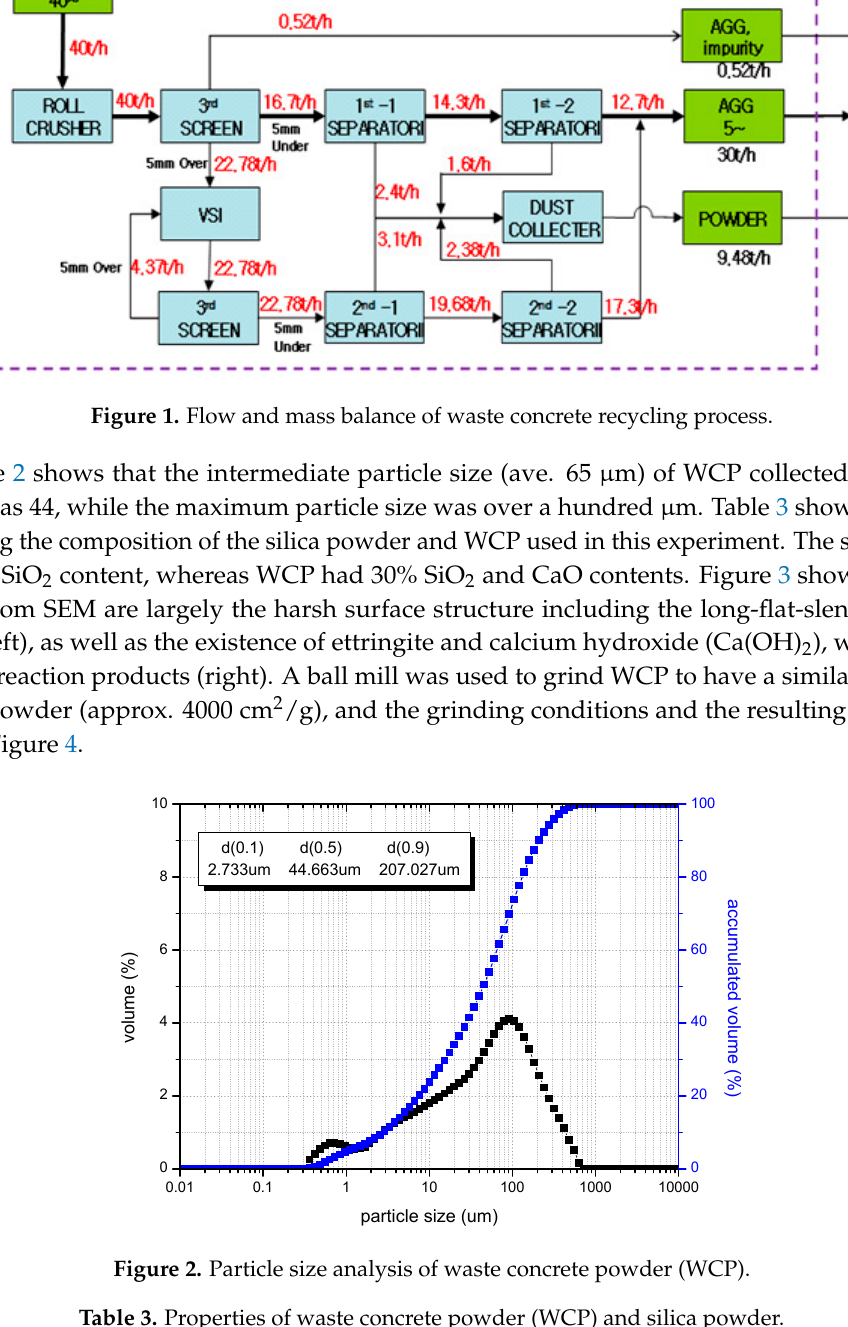
Figure 2. Particle size analysis of waste concrete powder (WCP). Table 3. Properties of waste concrete powder (WCP) and silica